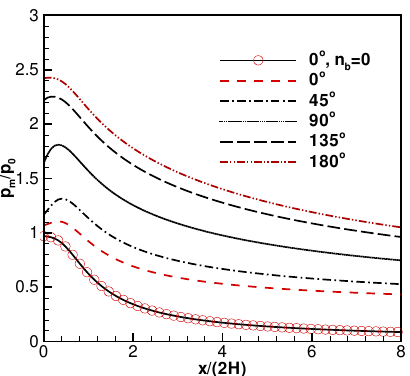
Figure 11. Background flow effects on centerline pressure profiles for the mixture, n b / n 0 = 0.2, S 0 = 2.0, S b = 1.0, T 0 = 200 Kelvin, and T b = 300